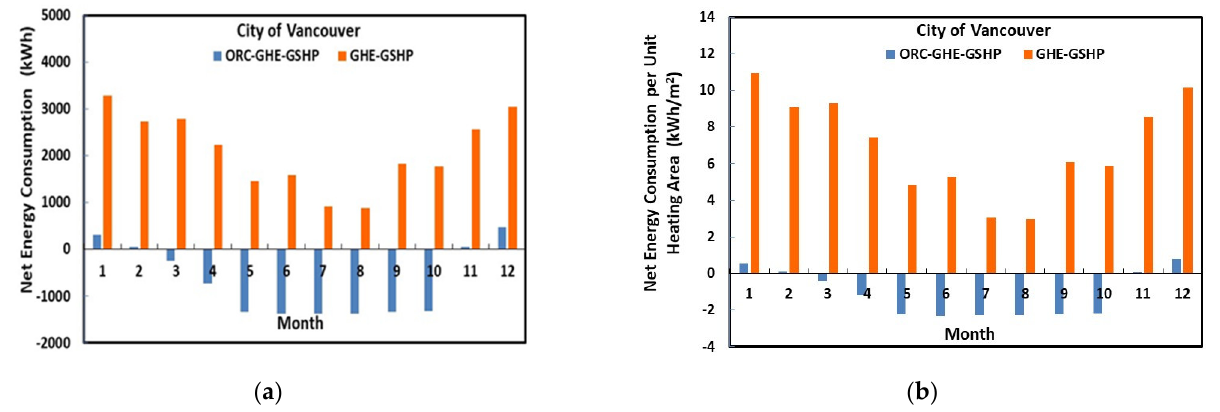
Figure 12. ( a ) Net energy consumption; ( b ) net energy consumption per unit heating area during the first year in Vancouver for ORC-GHE-GSHP and conventional GSHP systems.